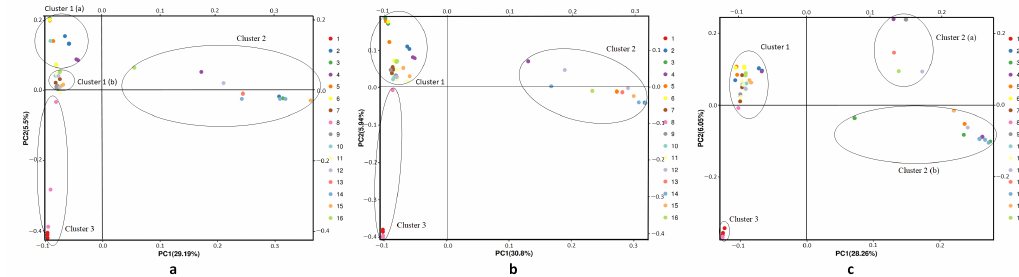
Figure 2. Principal component analysis (PCA) of 16 C. dactylon populations at di ff erent temperatures. Di ff erent colors indicate di ff erent populations. Black circles represent genetic clusters. ( a ) PCA of C. dactylon at 5 ◦ C. ( b ) PCA of C. dactylon at 20 ◦ C. ( c ) PCA of C. dactylon at 35 ◦ C.